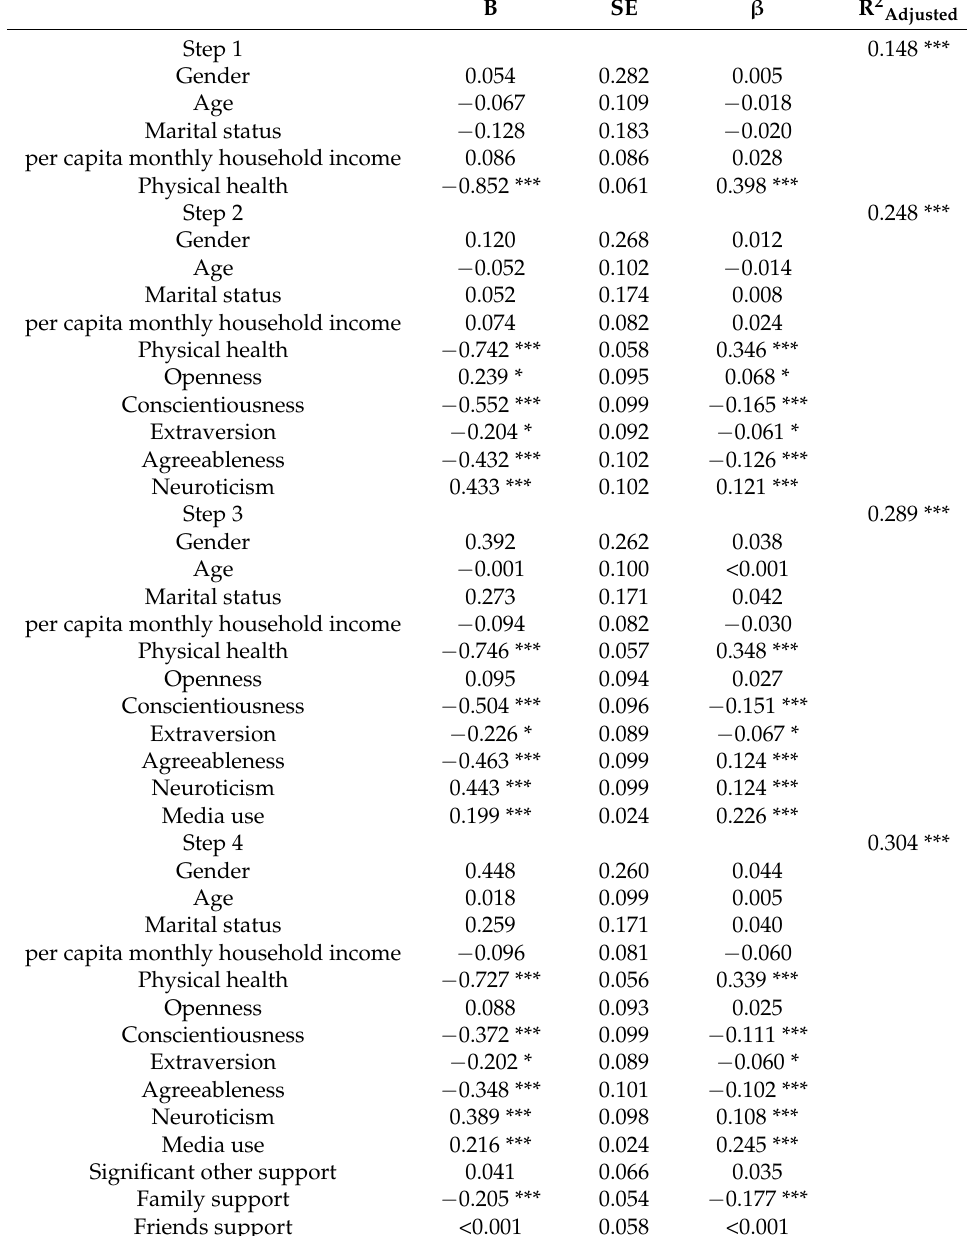
Table 3. The results of hierarchical